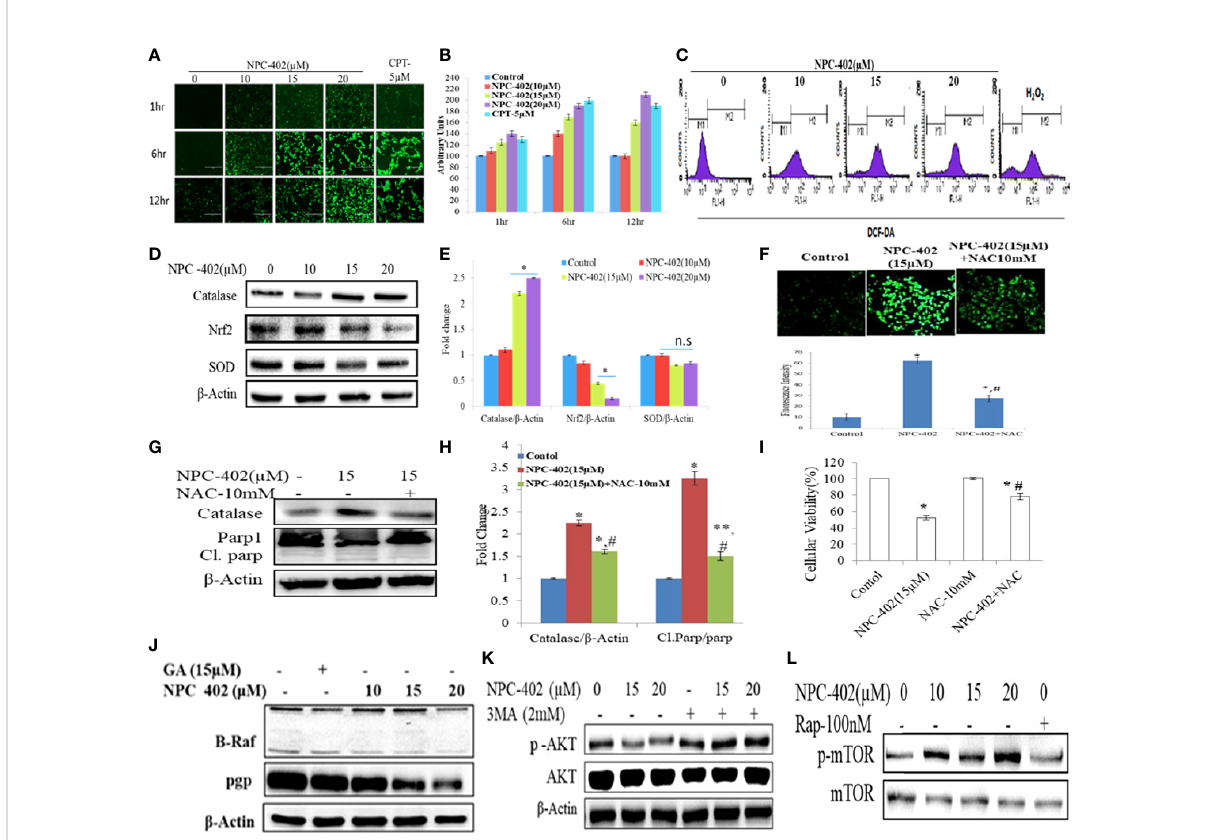
FIGURE 4 Induction of oxidative stress leads to apoptosis and inhibition of MAP kinase/AKT pathways in NPC-402-treated B16F10 cells. (A) Microscopic images represent time-dependent ROS fl uorescence in B16F10 cells treated with/without NPC-402 by using H 2 DFDA dye. (B) . Bar graphs represent fl uorescence intensity time- and dose-dependently in NPC-402-treated/without treatment B16F10 cells using ImageJ software. (C) Represents fl ow cytometric analysis of ROS generation dose-dependently in NPC-402-exposed B16F10 cells, and H 2 O 2 was used as an experimental control. (D) Represents Western blots of protein SOD, catalase, and Nrf2 in B16F10 cells treated with NPC-402. (E) Bar graph represents the densitometry analysis of catalase, Nrf2, and SOD using Image Lab ™ Software Version 3.0 (Bio-Rad). (F) Microscopic images represent the ROS fl uorescence by H 2 DFCA staining in B16F10 cells treated with NPC-402 or NAC or both, and the bar graphs represent ROS quanti fi cation thru ImageJ software. (G) Immunoblots of catalase, Parp1 in B16F10 cells treated with NPC-402/NAC or both. b -Actin was used as a loading control. (H) Bar graph represents the densitometry analysis of catalase, Parp1 in B16F10 cells treated with NPC-402/NAC or both using Image Lab ™ Software Version 3.0 (Bio-Rad). (I) Bar graph represents the cell viability analysis of B16F10 cells treated with/without NPC- 402 or NAC for 24 h using the MTT assay (* p < 0.001 control vs. NPC-402, # p < 0.001, NPC-402 vs. NPC-402+NAC) (* p < 0.001, control vs. NPC-402 treatment, ** p < 0.01, control vs. NPC-402 treatment, # p < 0.001, control vs. NAC treatment). (J) Immunoblot represents the protein expression of B-RAF and PGP using b -actin as a loading control in B16F10 cells treated with NPC-402. (K) Immunoblot represents the protein expression of p-AKT/AKT using b -actin as a loading control in B16F10 cells treated with NPC-402 and 3MA. (L) Immunoblots represent the protein expression of p-mTOR/mTOR using b -actin as a loading control in B16F10 cells treated with NPC-402. Rapamycin serves as a positive control (* p < 0.001, ** p < 0.01, control vs. NCP402